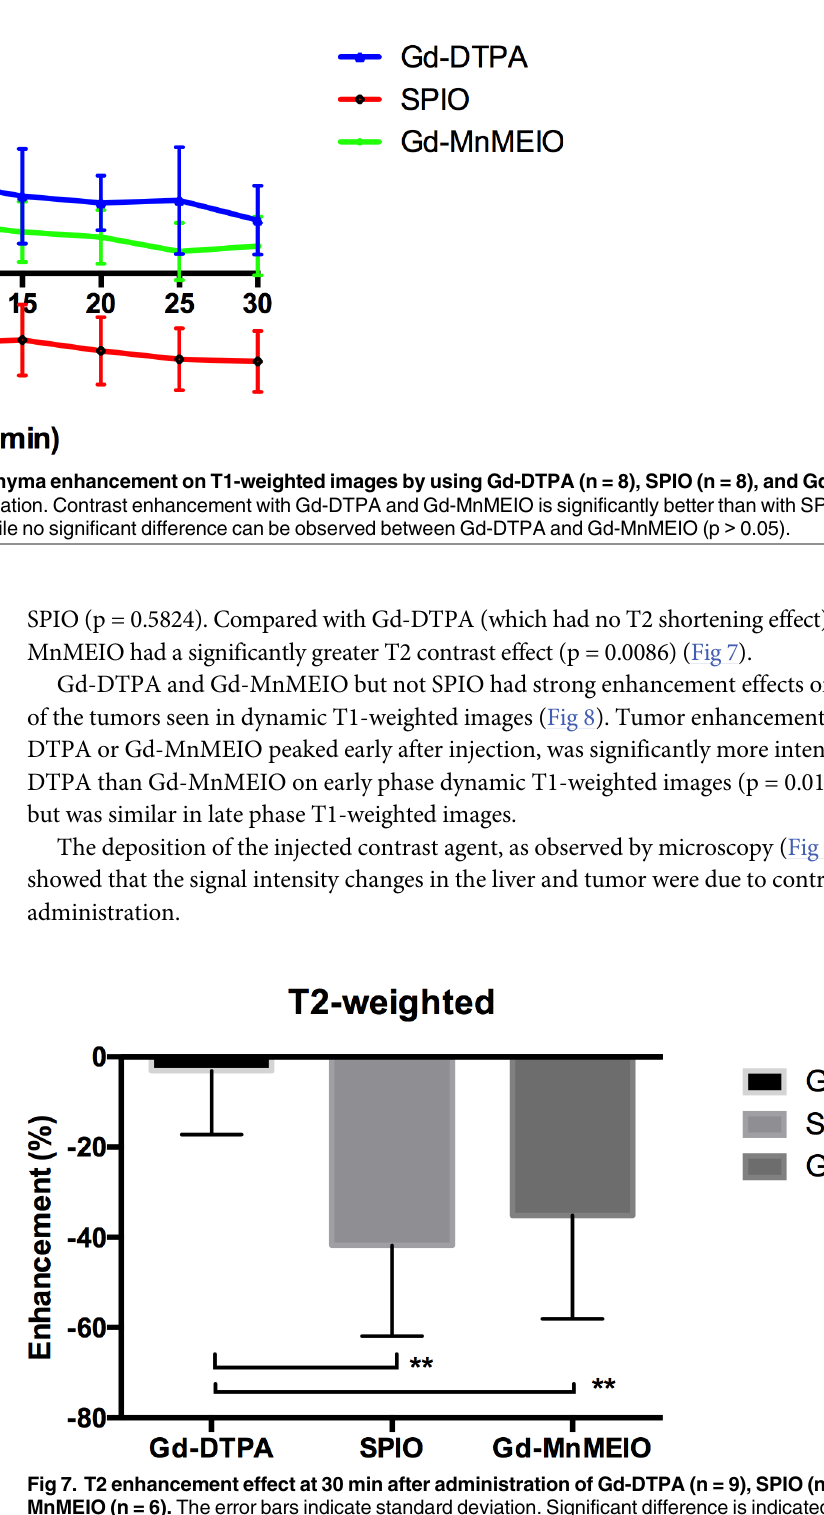
PLOS ONE | DOI:10.1371/journal.pone.0148695 February 17,